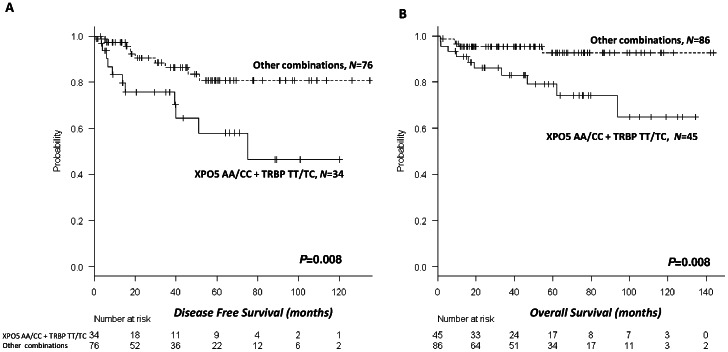
DFS and OS according to the combination of TRBP and XPO5 genotypes. Patients with both the XPO5 AA/CC and TRBP TT/TC genotypes had the worst prognosis. (A) DFS was 74 months (95% CI, 54–94) for patients with the unfavorable combination, compared to 114 months (95% CI, 102–126) for those with other combinations (P = 0.008). (B) OS was 103 months (95% CI, 86–120) for patients with the unfavorable combination and 135 months (95% CI, 128–143) for those with other combinations (P = 0.008).